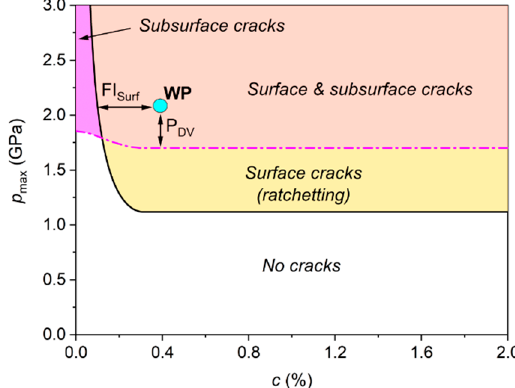
Figure 7. RCF map visualizing the limits of crack initiation at surface and subsurface locations based on local contact variables. The material and contact parameters used to calculate the RCF map are stated in the main text.